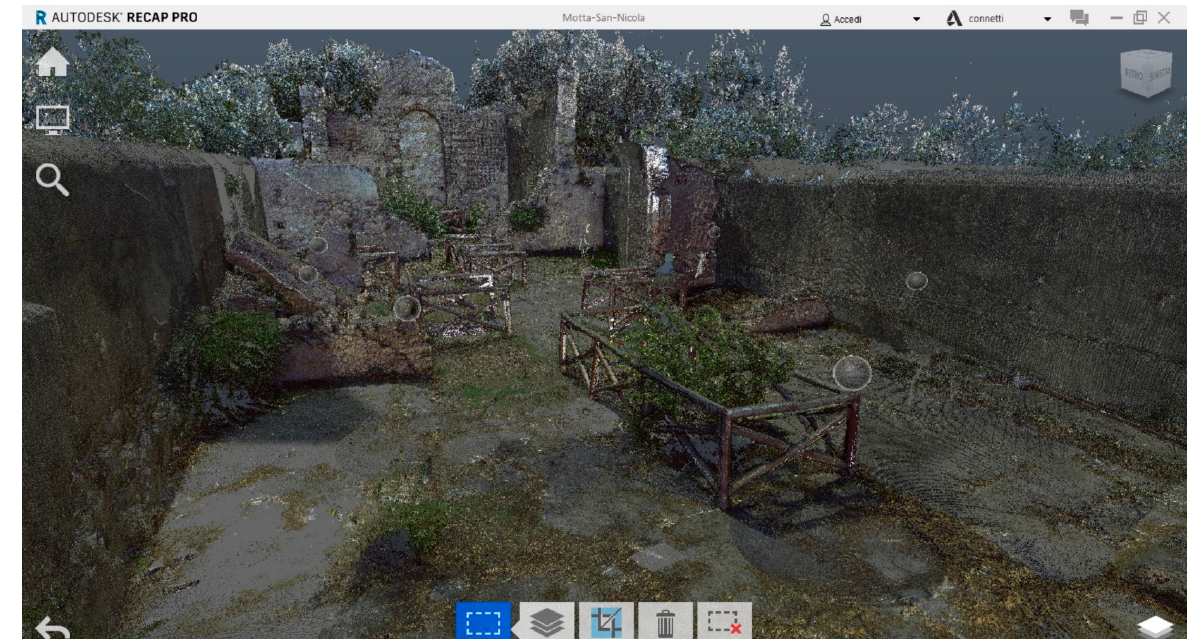
Figure 15. Dense cloud export options.